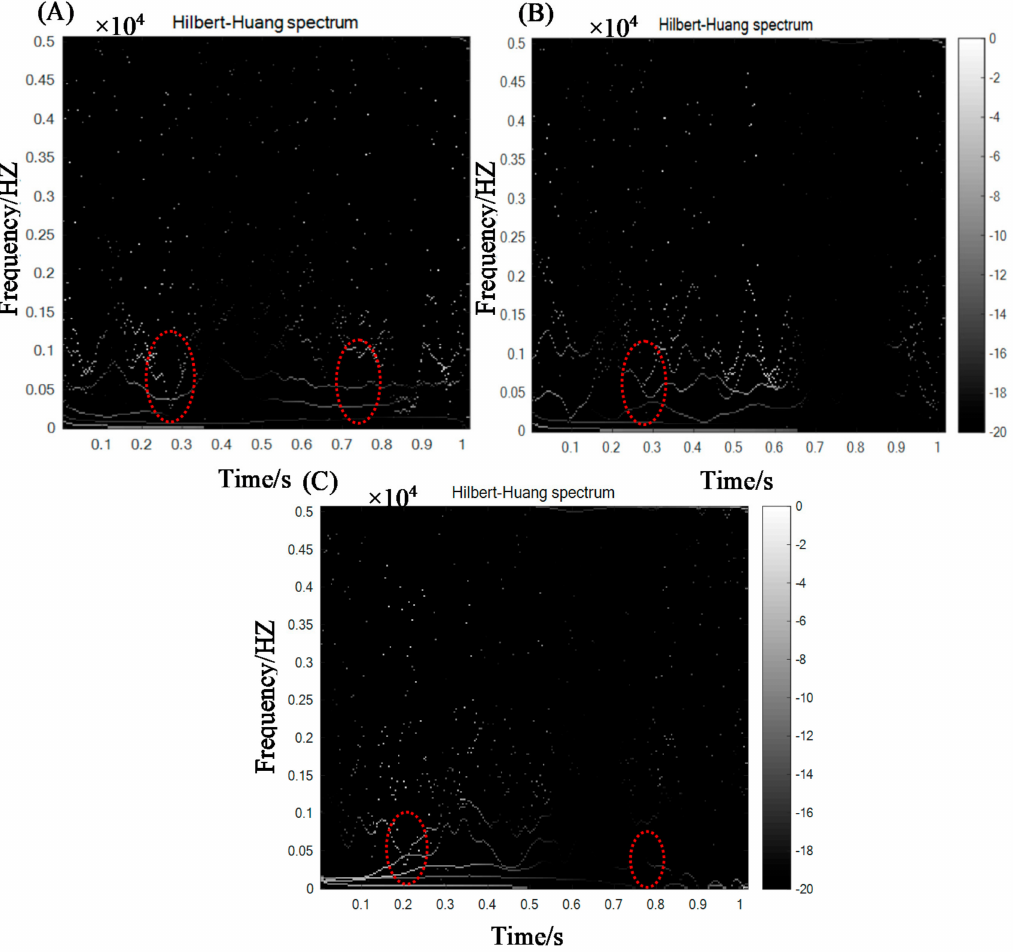
Figure 11. Hilbert–Huang transform (HHT) spectra of the AE signal for samples ( A ) B-V1, ( B ) B-V2, and ( C ) B-V3 samples. The areas around the sudden changes in the bright line are circled in